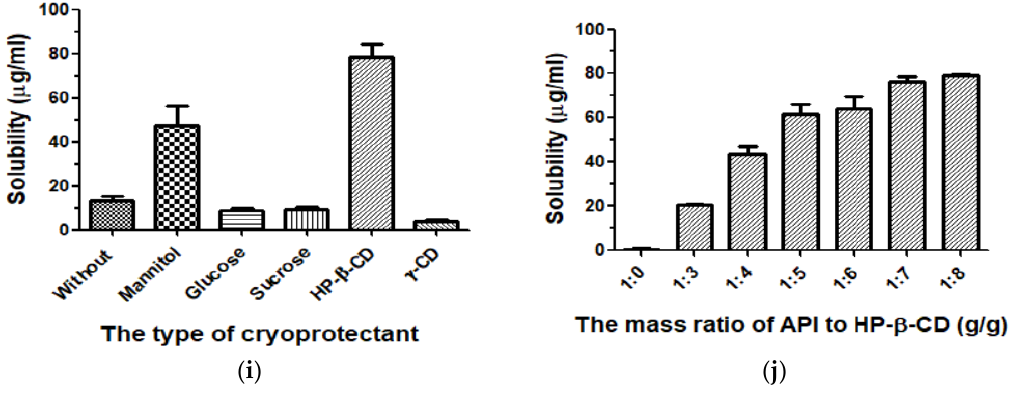
Figure 3. The effects of each factor on API nanoparticles. ( a ) Type of surfactant, ( b ) tween 80 concentration, ( c ) API concentration, ( d ) the volume ratio of antisolvent/solvent, ( e ) stirring speed, ( f ) stirring time, ( g ) precipitation temperature, ( h ) dropping speed, ( i ) type of cryoprotectant, and ( j ) the mass ratio of API/HP- β -CD.